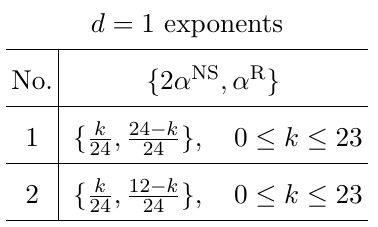
Table 2 . All possible exponents mod 1 for rank 1